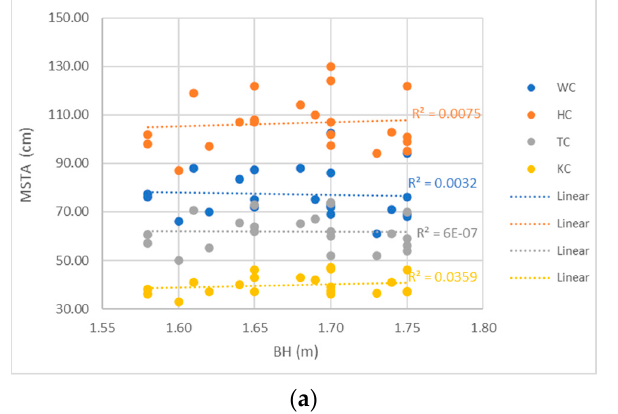
Table 5. The analyses of measured circumferences show that, with increasing body weight (BW) and body mass index (BMI), WC, HC, TC and KC increase, while no effect of body height (BH) on the measured circumferences was been observed for a standing (Figure 4) or sitting (Figure 5) posture.